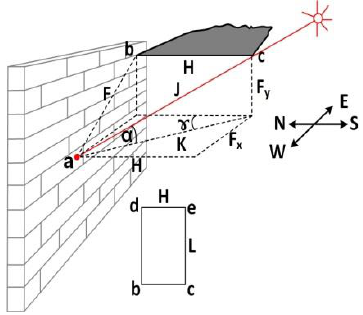
Figure 4. Horizontal plate attached perpendicular to a wall.